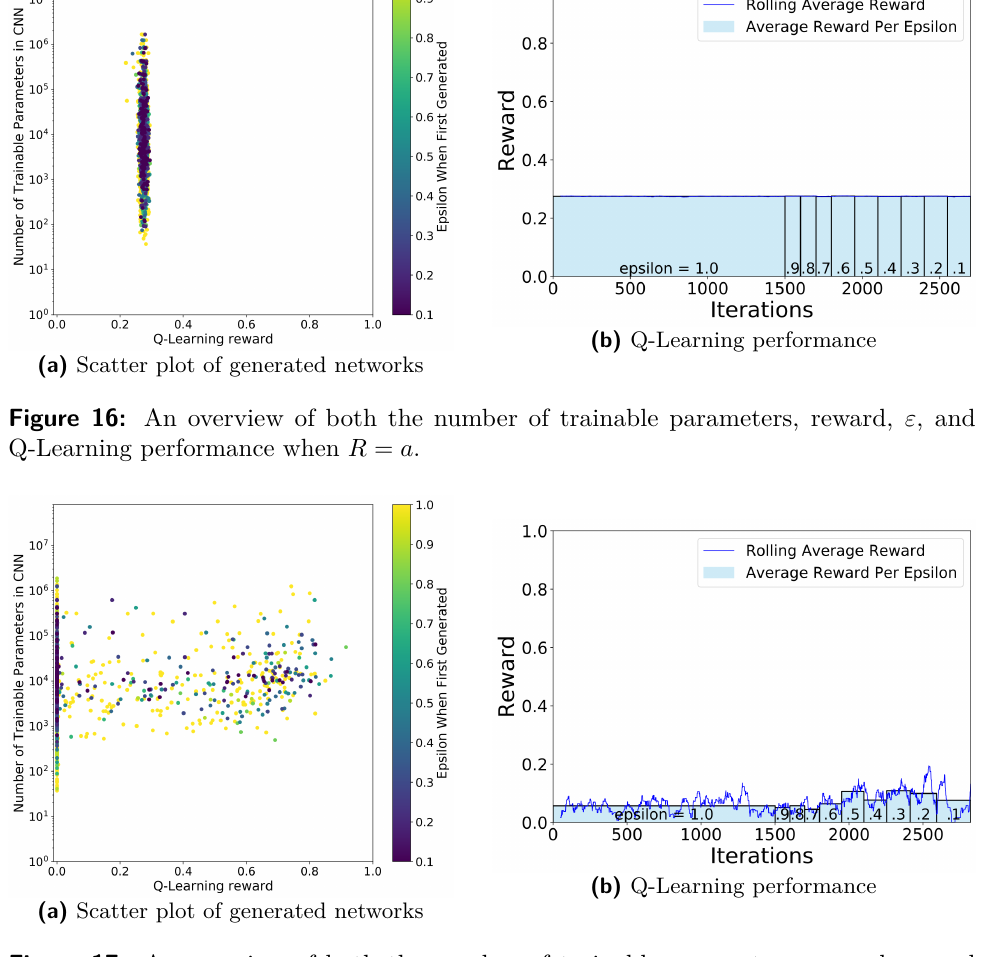
Figure 17: An overview of both the number of trainable parameters, reward, ε , and Q-Learning performance when R = GE 0 10